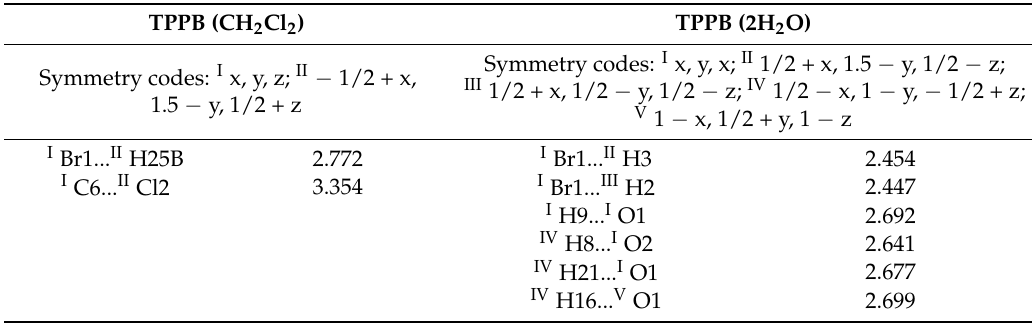
Table 1. Intermolecular contacts of TPPB to the solvent molecules shorter than the sum of the van der Waals (vdW) radii in the solvated crystals.